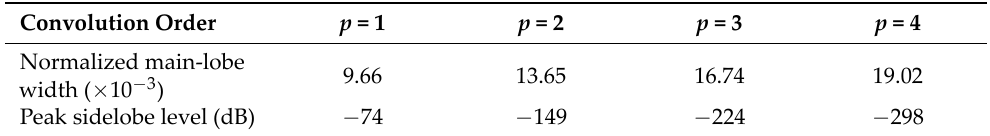
Table 4. The effect of p on the frequency